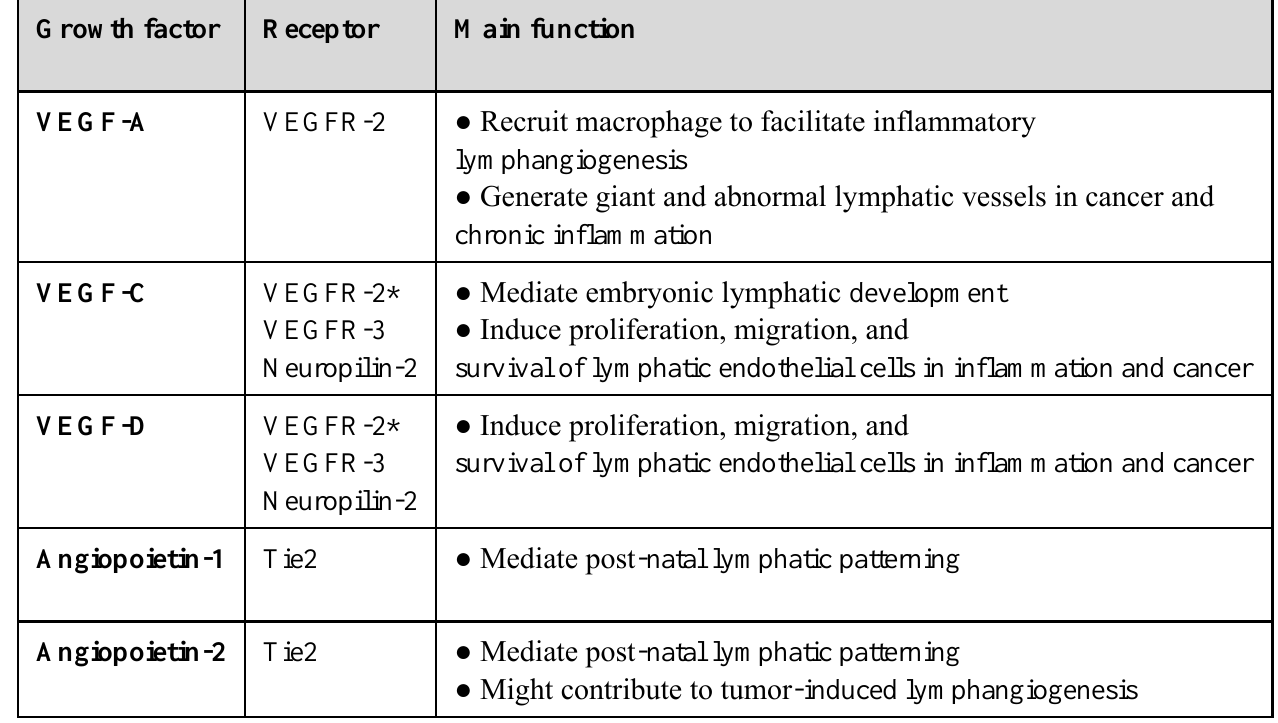
Table1. Growth factors involved in